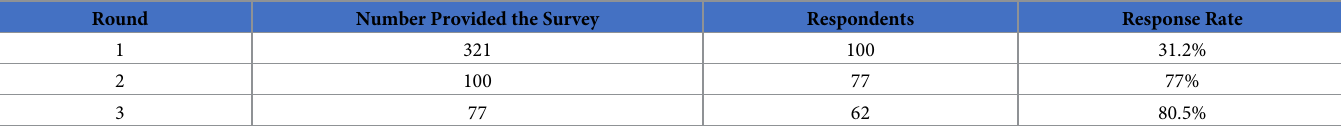
Table 2. Response rate by